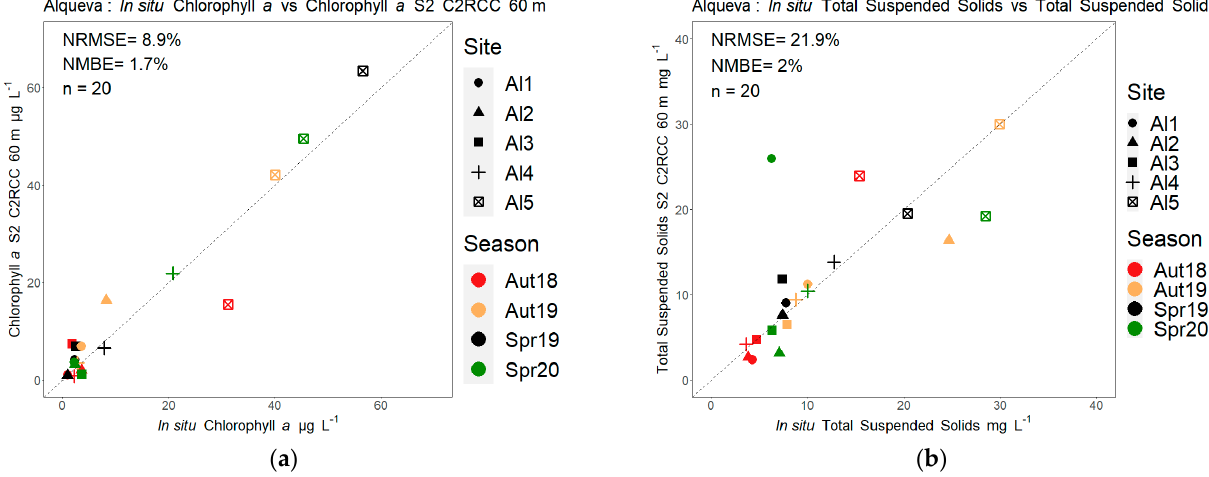
Figure 6. Correlation between ( a ) in situ and SNAP-C2RCC chlorophyll a values and ( b ) in situ total suspended solids and SNAP-C2RCC total suspended solids values for the Alqueva reservoir, using the 60 m product. Normalized root mean squared error (NRMSE), normalized mean bias error (NMBE), number of observations (n) and dashed X = Y lines are also presented.